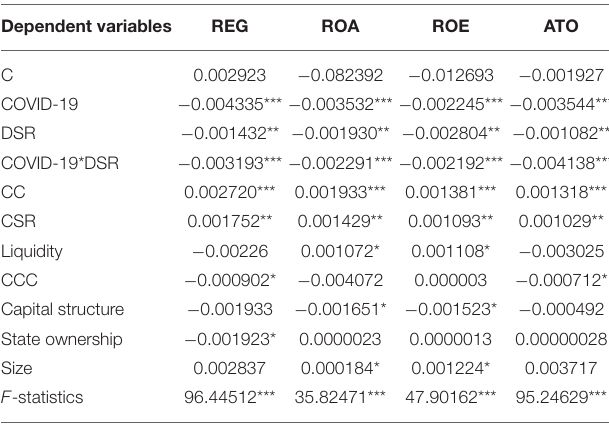
TABLE 8 | Generalized linear regression in Chinese different zones.